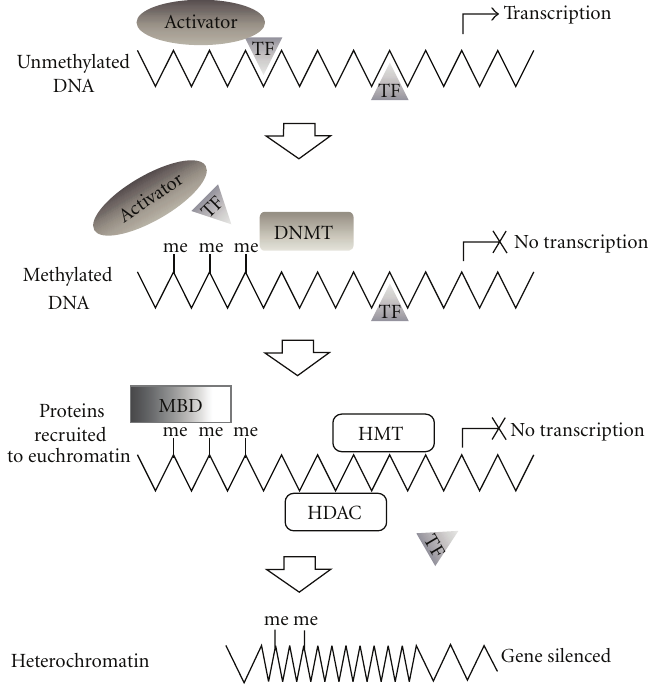
Figure 2: Mechanisms of epigenetic gene silencing. Unmethylated DNA is accessible to activator proteins and transcription factors (TF) enabling transcription. DNA methylation by DNA methyl transferases (DNMT) causes steric inhibition of transcription complexes thus blocking transcription. Methylated DNA (me) is recognized by methyl binding domain proteins (MBD), histone deacetylases (HDAC), and histone methyltransferases (HMT) which stimulate chromatin remodeling. Compaction of DNA into condensed chromatin (heterochromatin) results in transcriptionally inactive